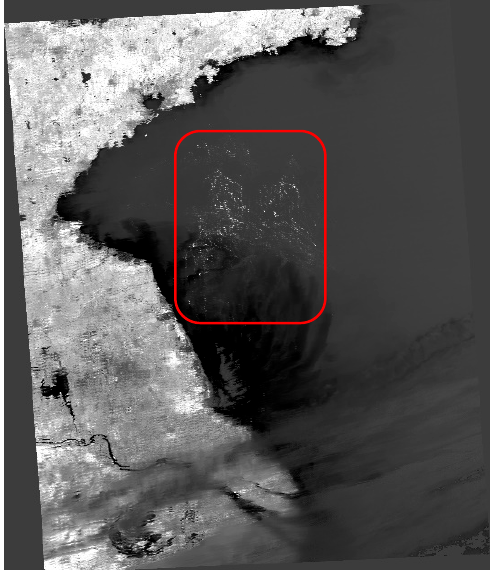
Figure 4. MODIS image on 4 June 2021 after DVI processing.